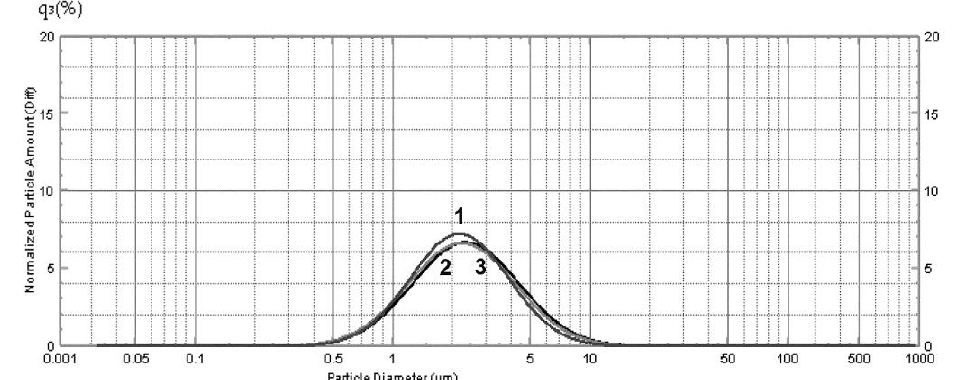
Fig. 1. Particle size distribution for SS in the pMDI No. 1, pMDI No. 2 and pMDI No. 3 The maximum size of SS particle (D) in different fractions containing from 10 % to 90 % of particles from their total